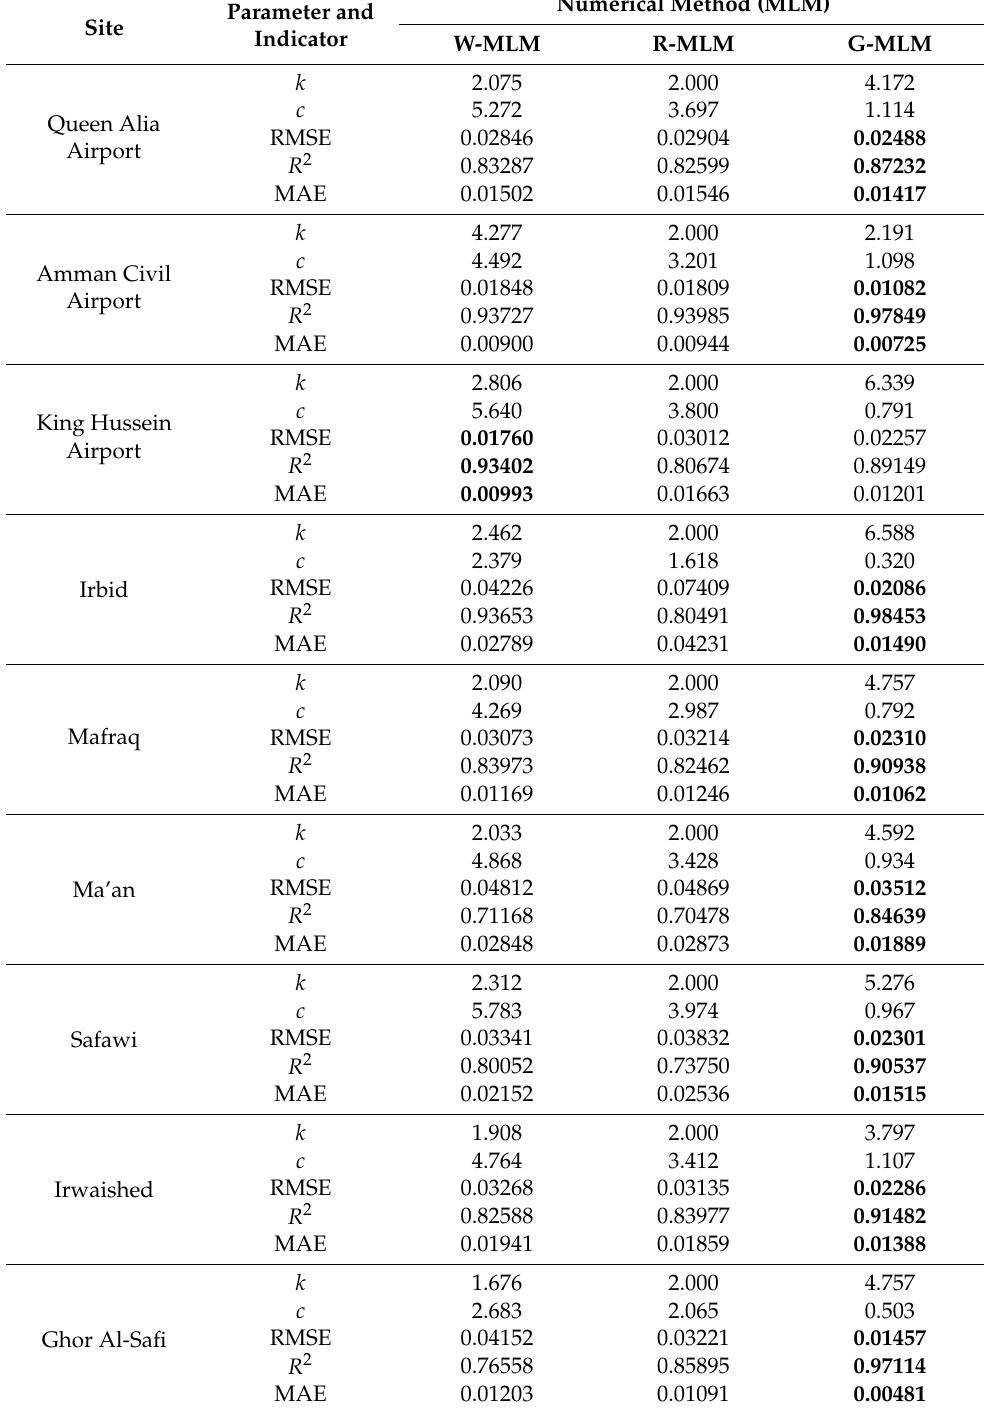
Table 3. Distribution model parameters and performance indicator results based on numerical estimation method